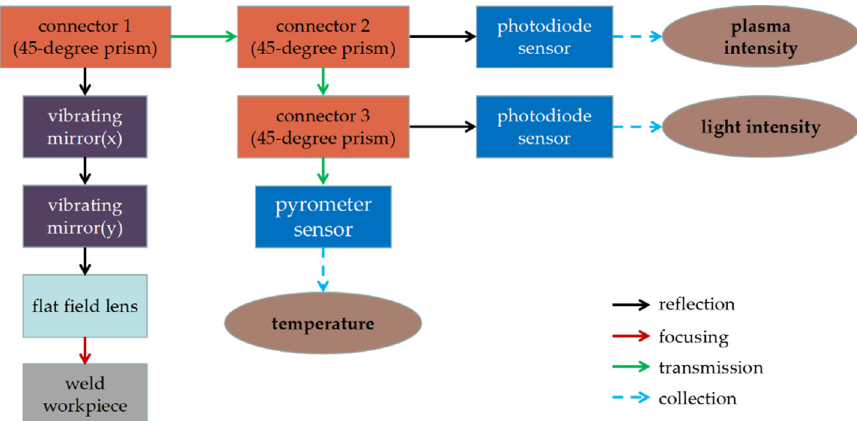
Figure 2. Structure diagram of data acquisition system.